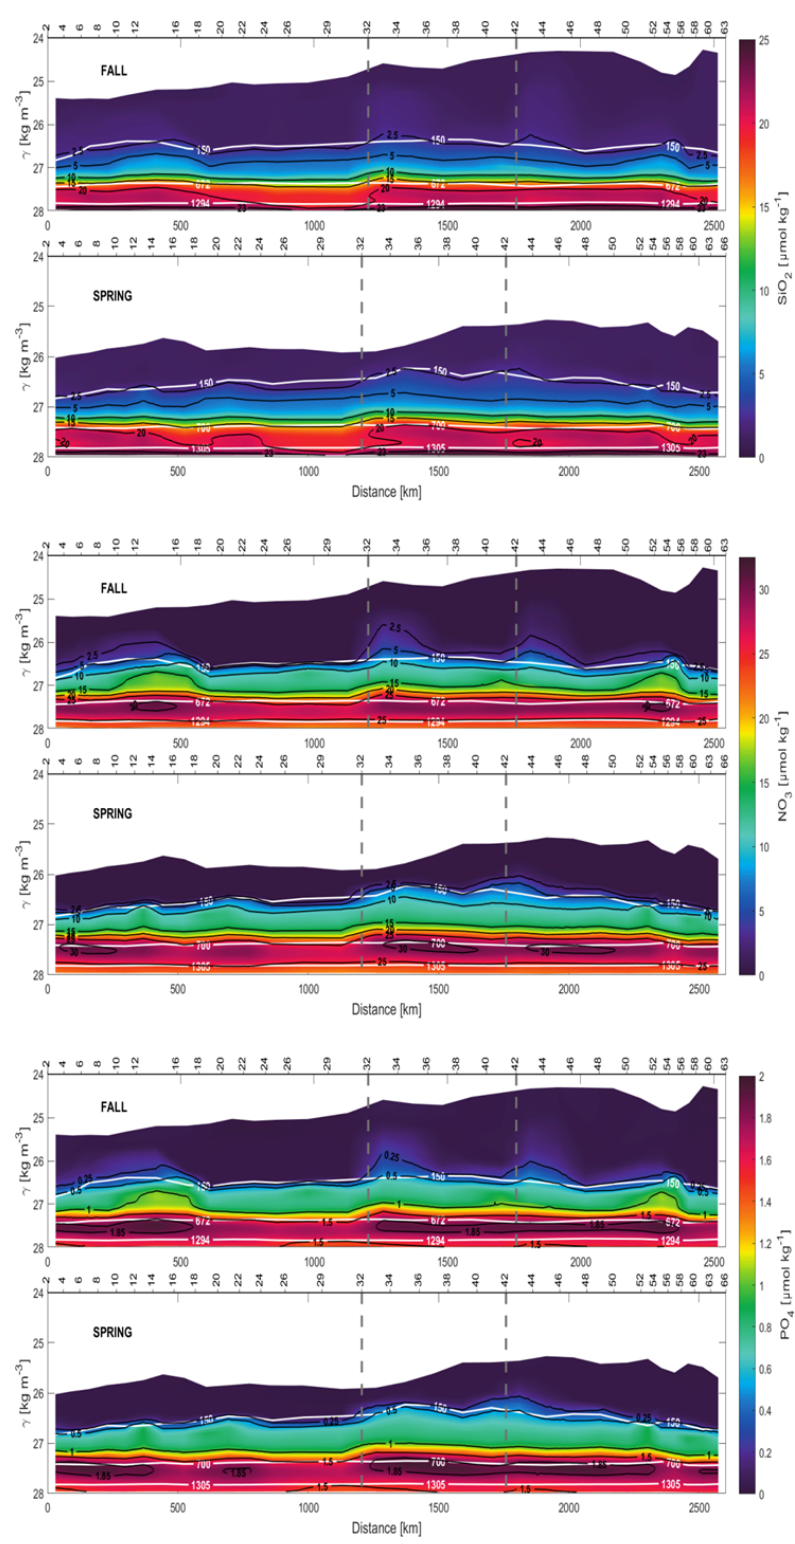
Figure 7. Sections for SiO 2 (top), NO 3 (middle) and PO 4 (bottom) concentrations with respect to γ n during fall (top) and spring (bottom) extracted from GLORYS-BIO. The white isolines are as in the γ n sections in Figs. 4 and